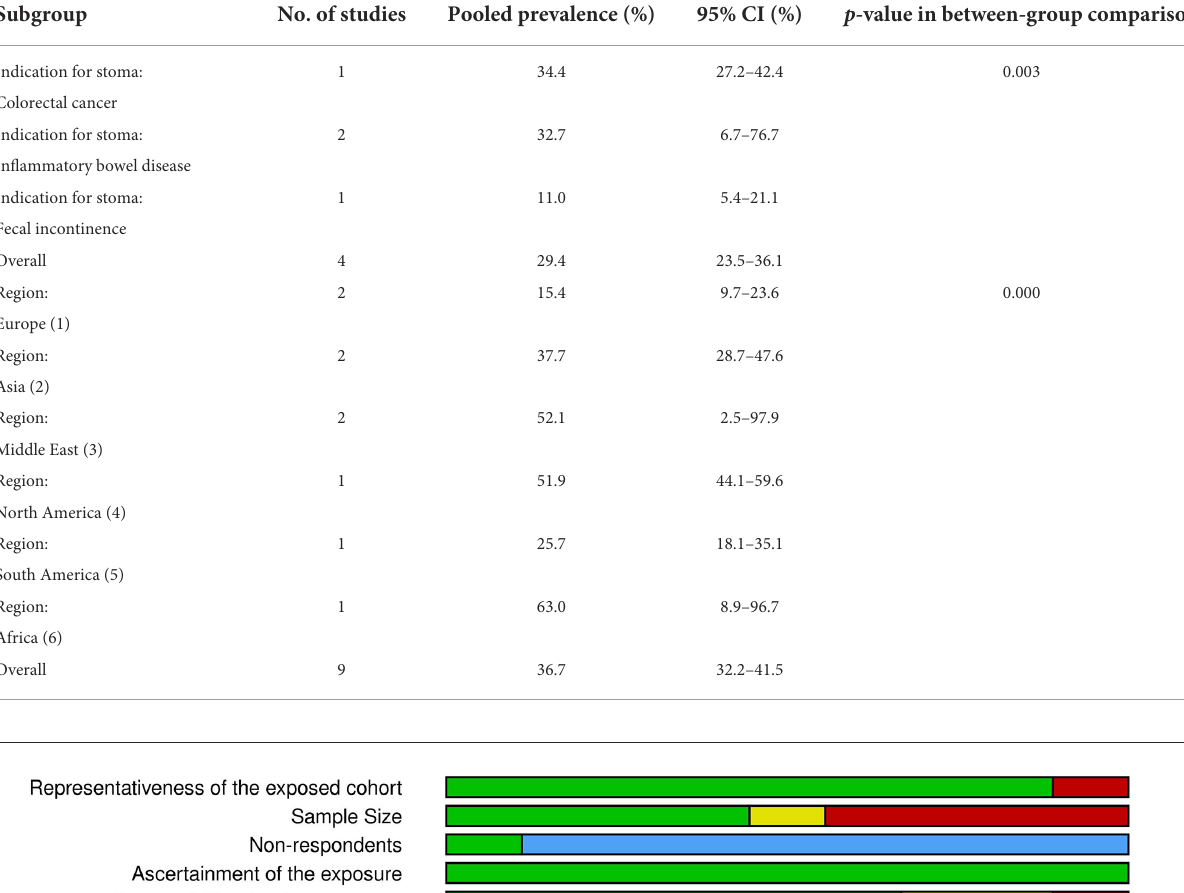
TABLE 3 Subgroup analysis on selected sources of heterogeneity.